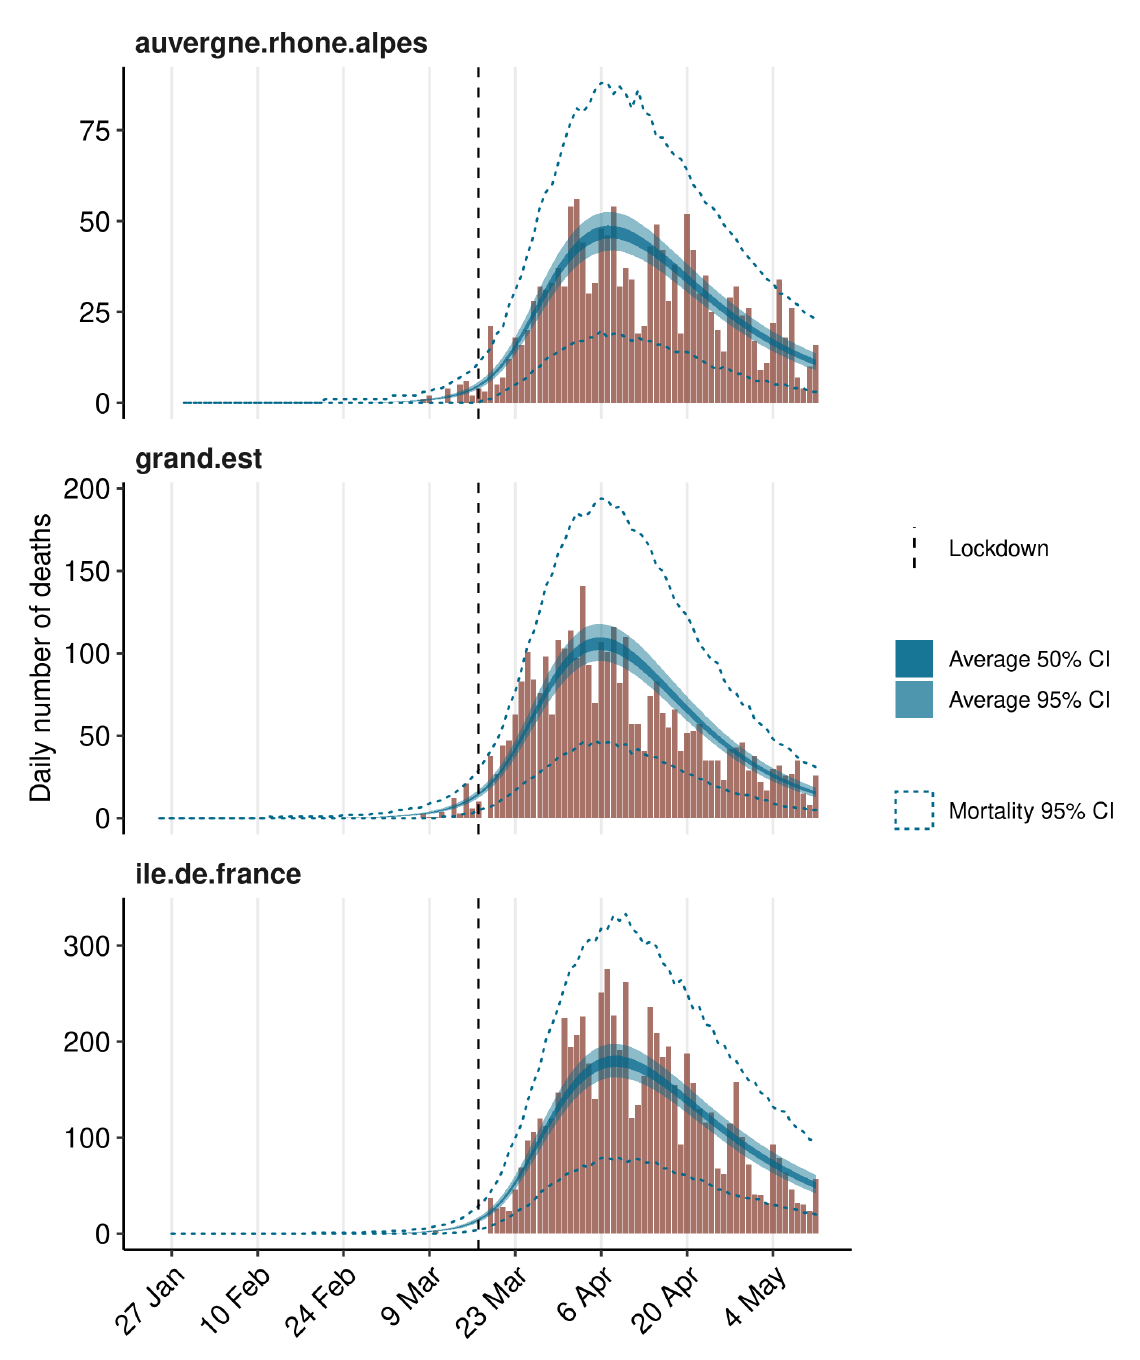
Figure 3 – Model fit on the complete dataset for three different